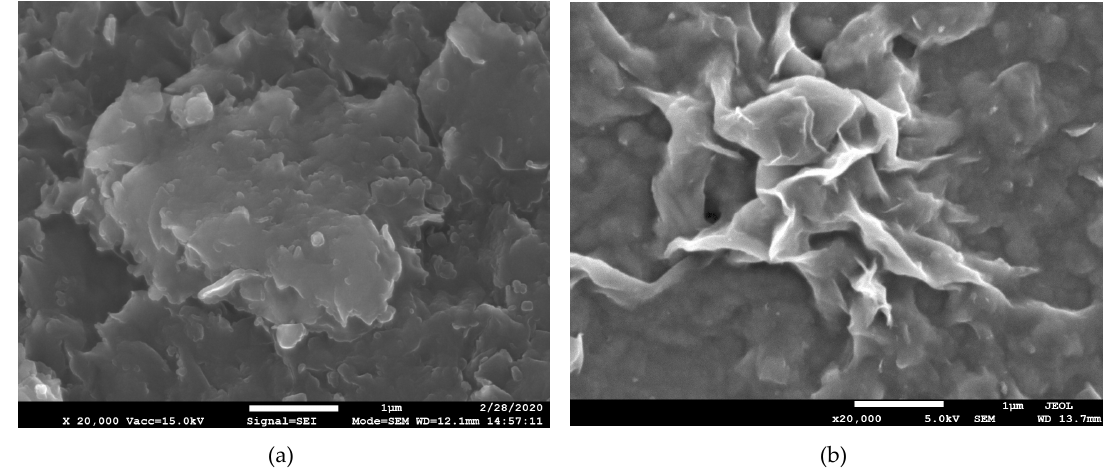
Figure 3. SEM images of Na-montmorillonite powder 20k × magnification: ( a ) raw sample; ( b ) highly purified sample.